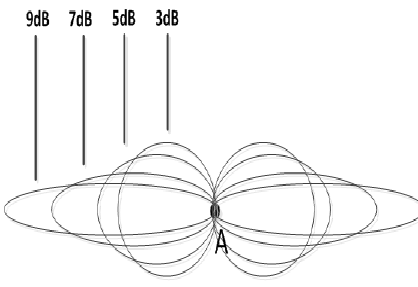
Figure 3. Schematic diagram of the possible area.